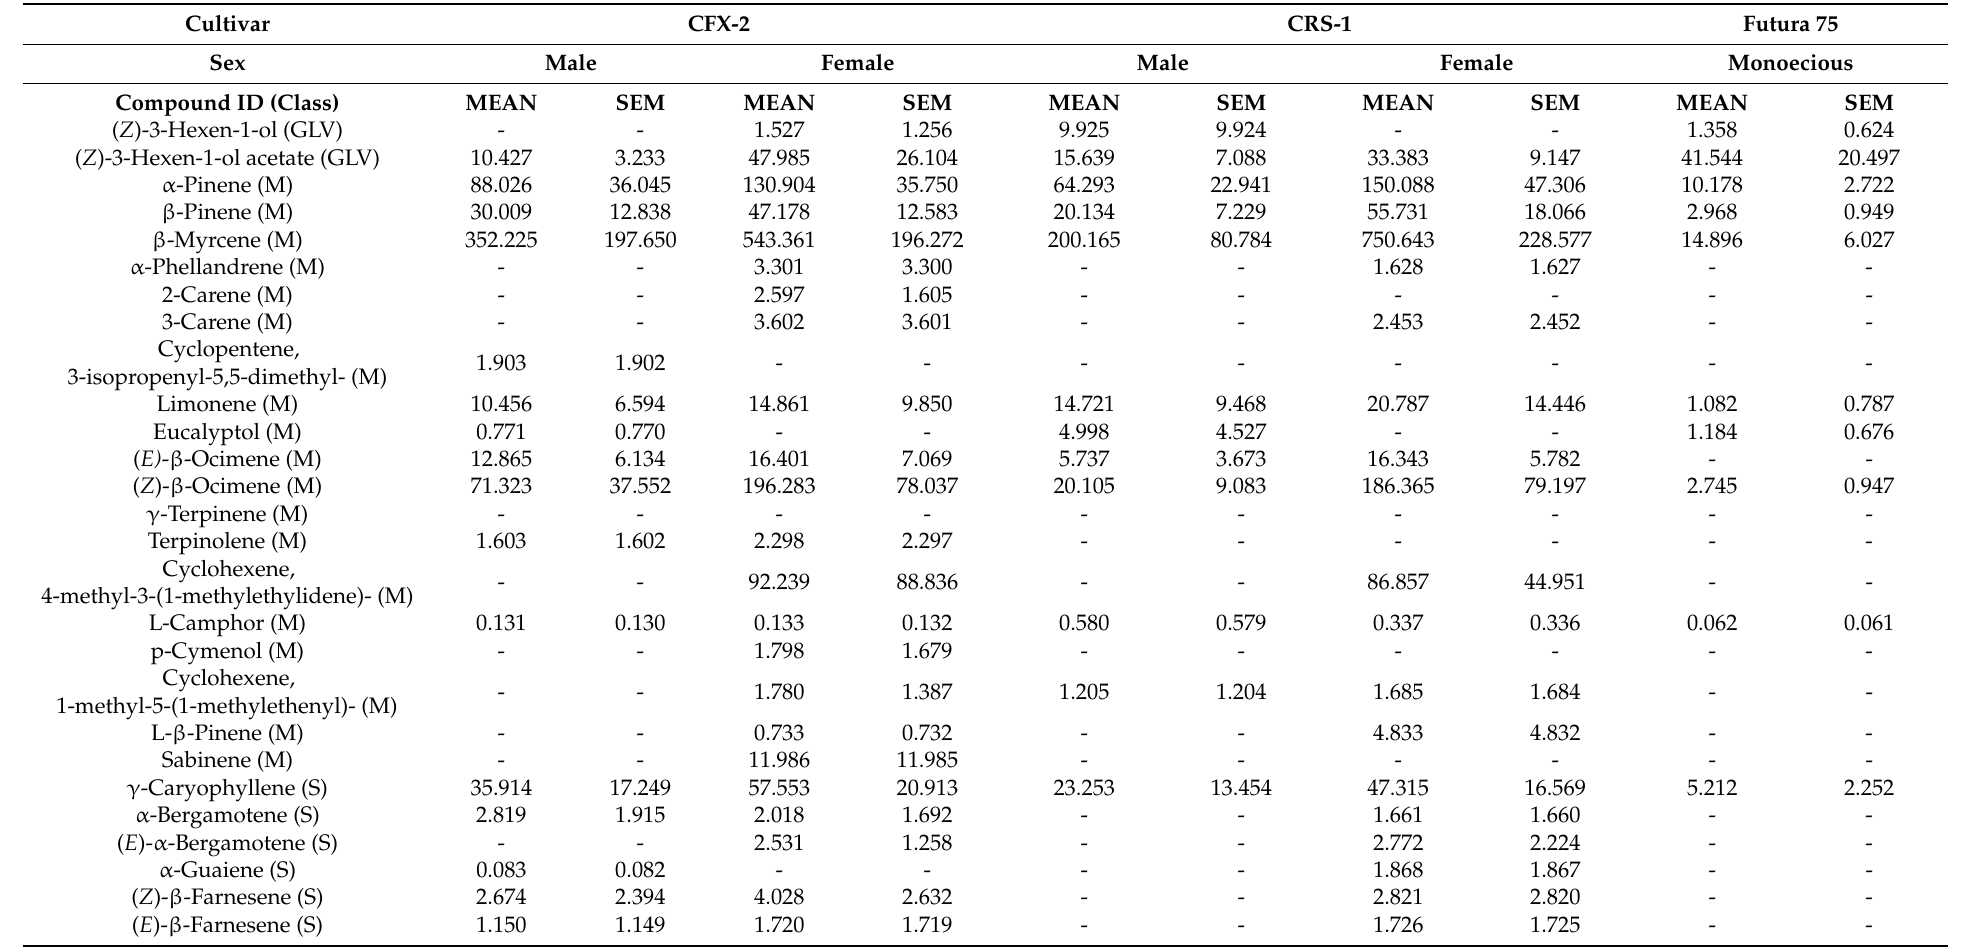
Table 2. Identification and quantification of compounds present (ng gDW − 1 h − 1 ) in the headspace samples of six hemp cultivars. Data are presented